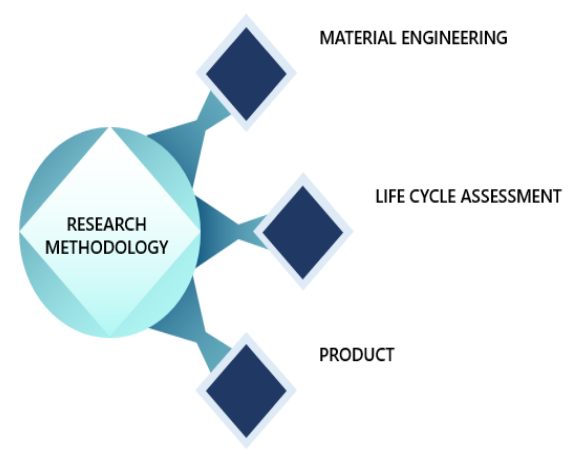
Figure 9. Procedure for AM testing [28].